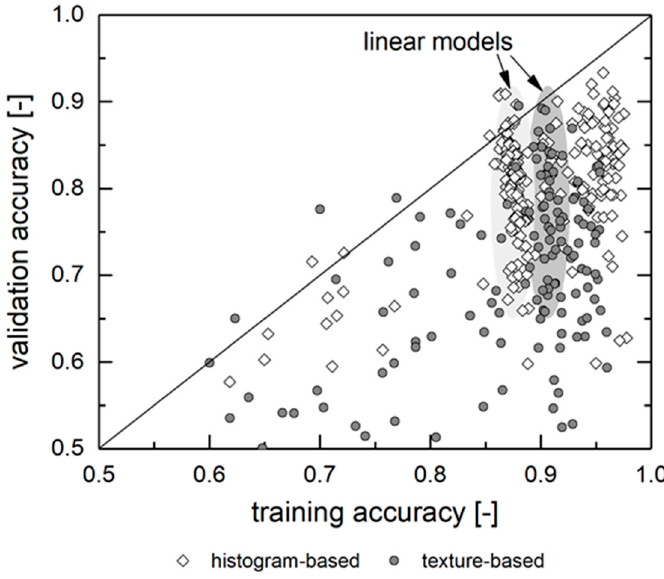
Figure 7. Relation between training and validation accuracy (as R 2 ) of the predicted fuel quality for both feature vector types.